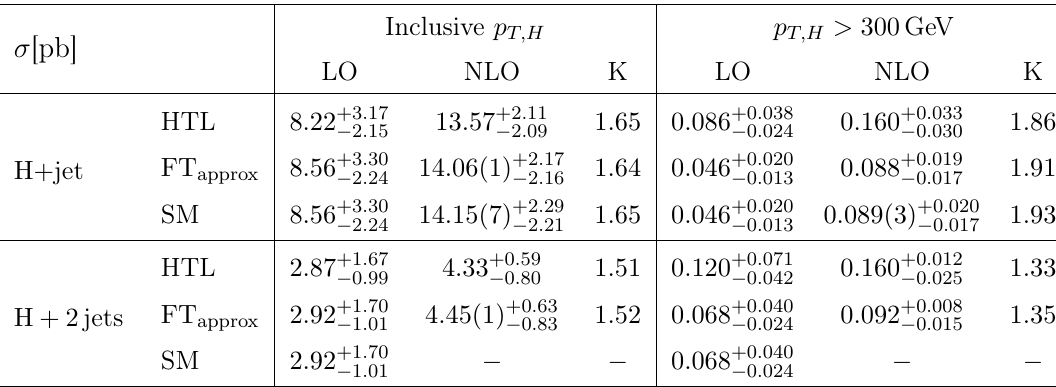
Table 2 . Integrated cross sections at LO and NLO in the HTL and FT approx approximations and with full top-quark mass dependence (SM) for H+ jet and H+2 jets production together with corresponding K-factors. Uncertainties correspond to the envelope of 7-point scale variations. For H+ jet production we require p T ; j > 30 GeV , while for H + 2 jets production we require p T ; j On the left no further phase-space restrictions are considered, while on the right we additionally require p T;H > 300 GeV . Numerical integration errors larger than permil level are indicated in